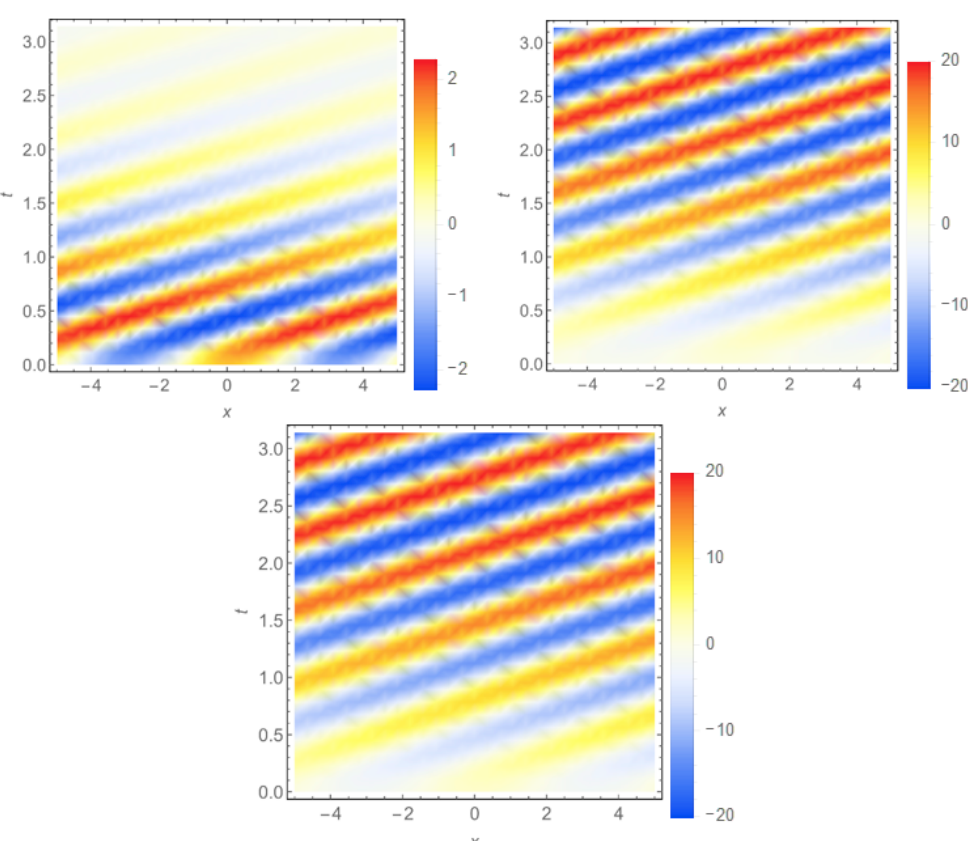
Figure 2. Evolution of quasi-temperature components in a thin film with Kn b = Kn d = 1 for v = +10: θ b ( x , t ) —top left plot, θ d ( x , t ) —top right plot and θ ( x , t ) = θ b ( x , t ) + θ d ( x , t ) —bottom plot. The Cauchy conditions for PDEs (9) and (10) system are θ b ( x ,0 ) = θ d ( x ,0 ) = e inx , ∂ t θ b ( x ,0 ) = ∂ t θ d ( x ,0 ) =